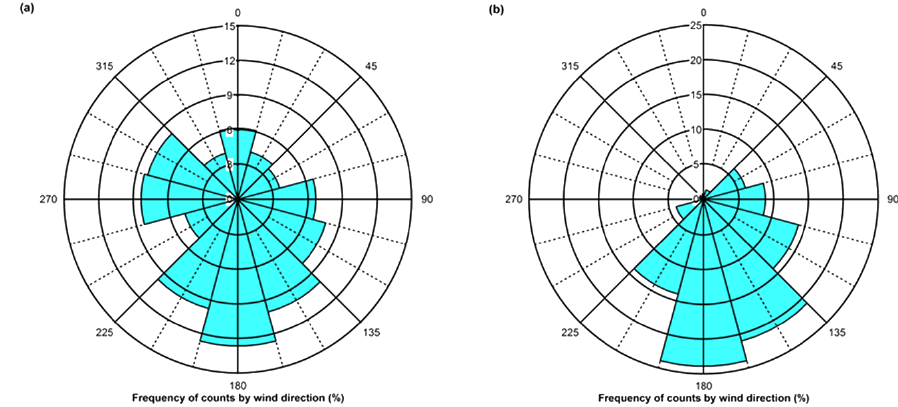
Figure 2. Wind roses for two low wind speed situations. (a) Wind rose for 10–11 November 2013 (significant peak in mole fractions). (b) Wind rose for 18 November 2013 (no significant peak in mole fractions). The percent scale is not the same for the two wind plots.